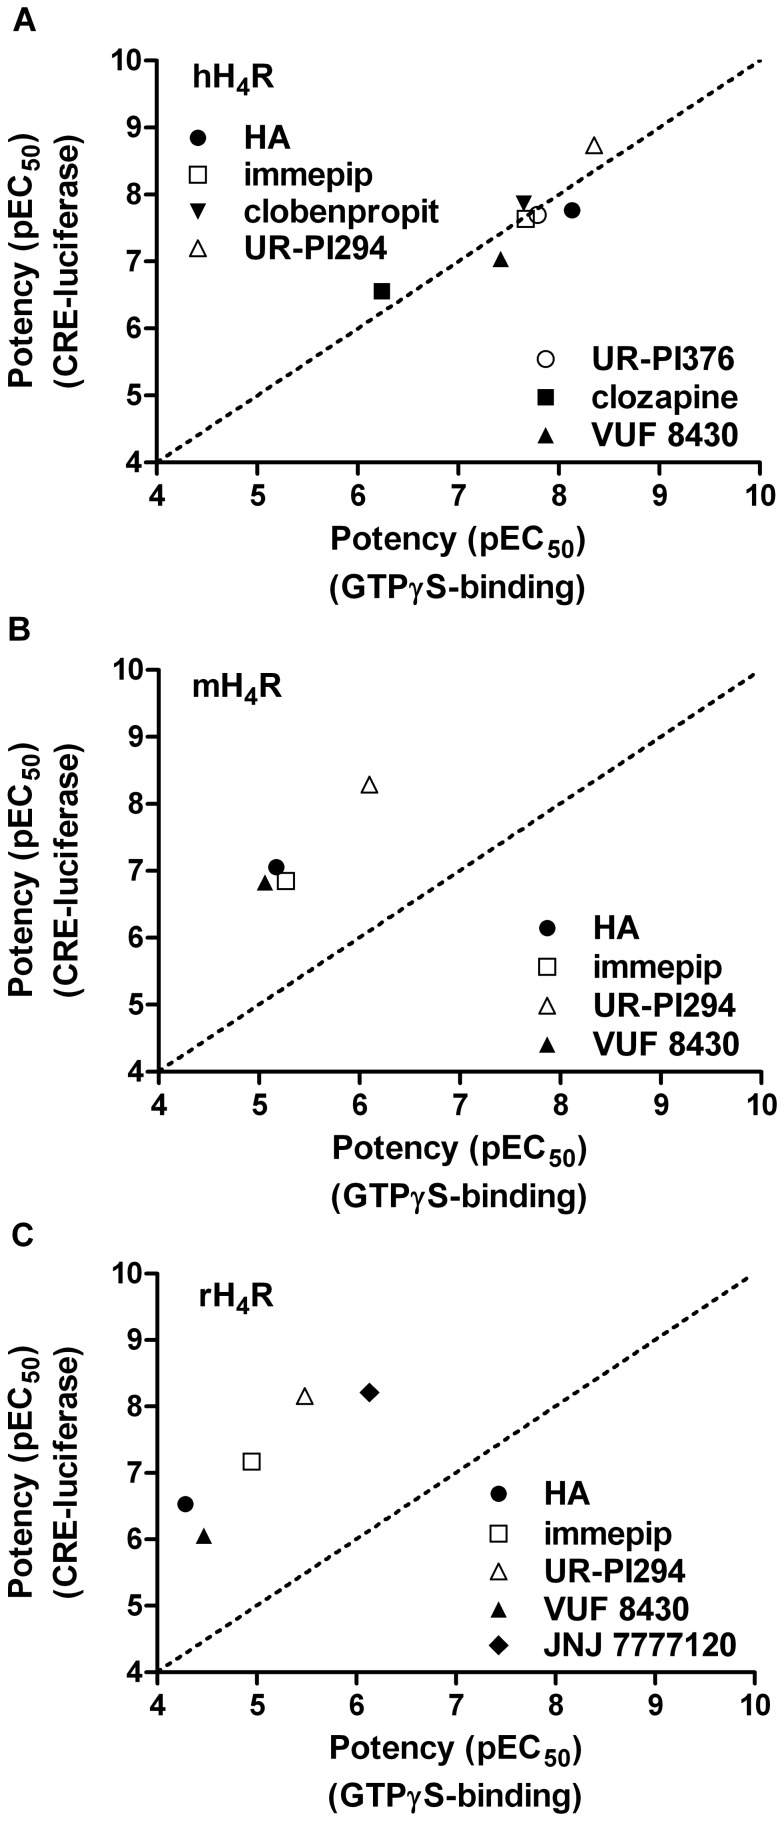
Comparison of distal and proximal readouts.Correlation between agonist potencies in the luciferase reporter gene assay and the [35S]GTPγS assay at the (A) hH4R (slope: 0.90±0.20; r2 = 0.80), (B) mH4R (slope: 1.431±0.23; r2 = 0.95) and (C) rH4R (slope: 1.171±0.28, r2 = 0.85).